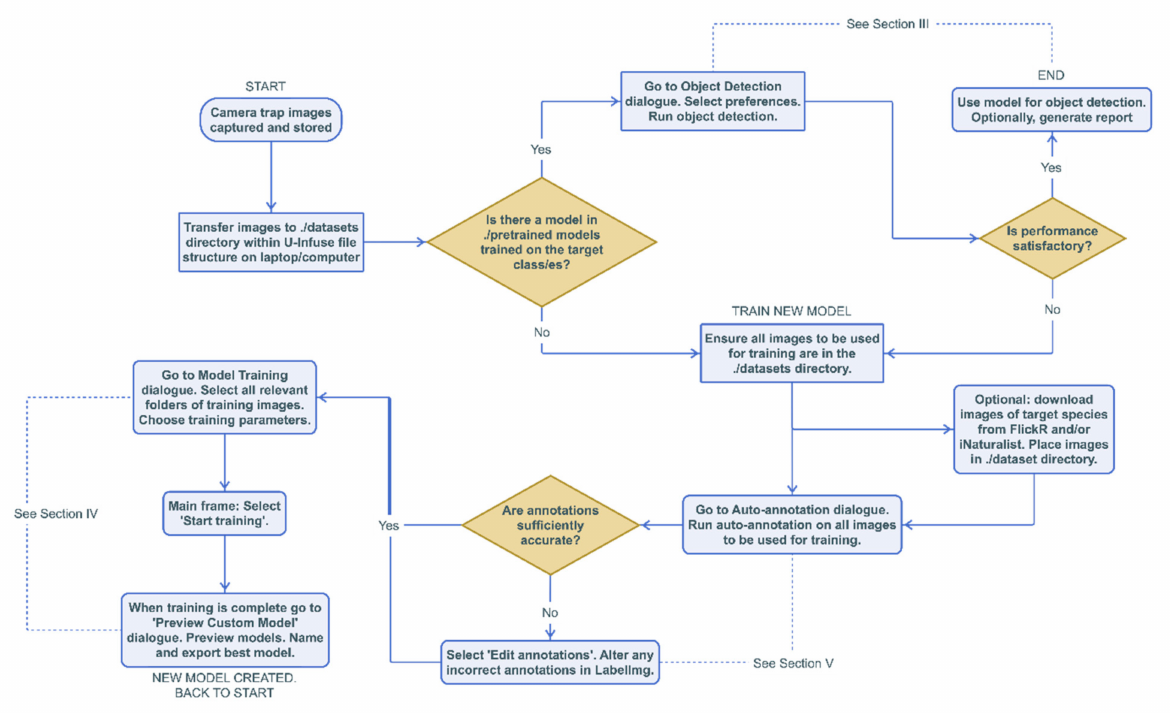
Figure 1. Sample workflow diagram demonstrating pipeline useability. Please refer to [30] for best practices when using FlickR and iNaturalist (FiN) images.